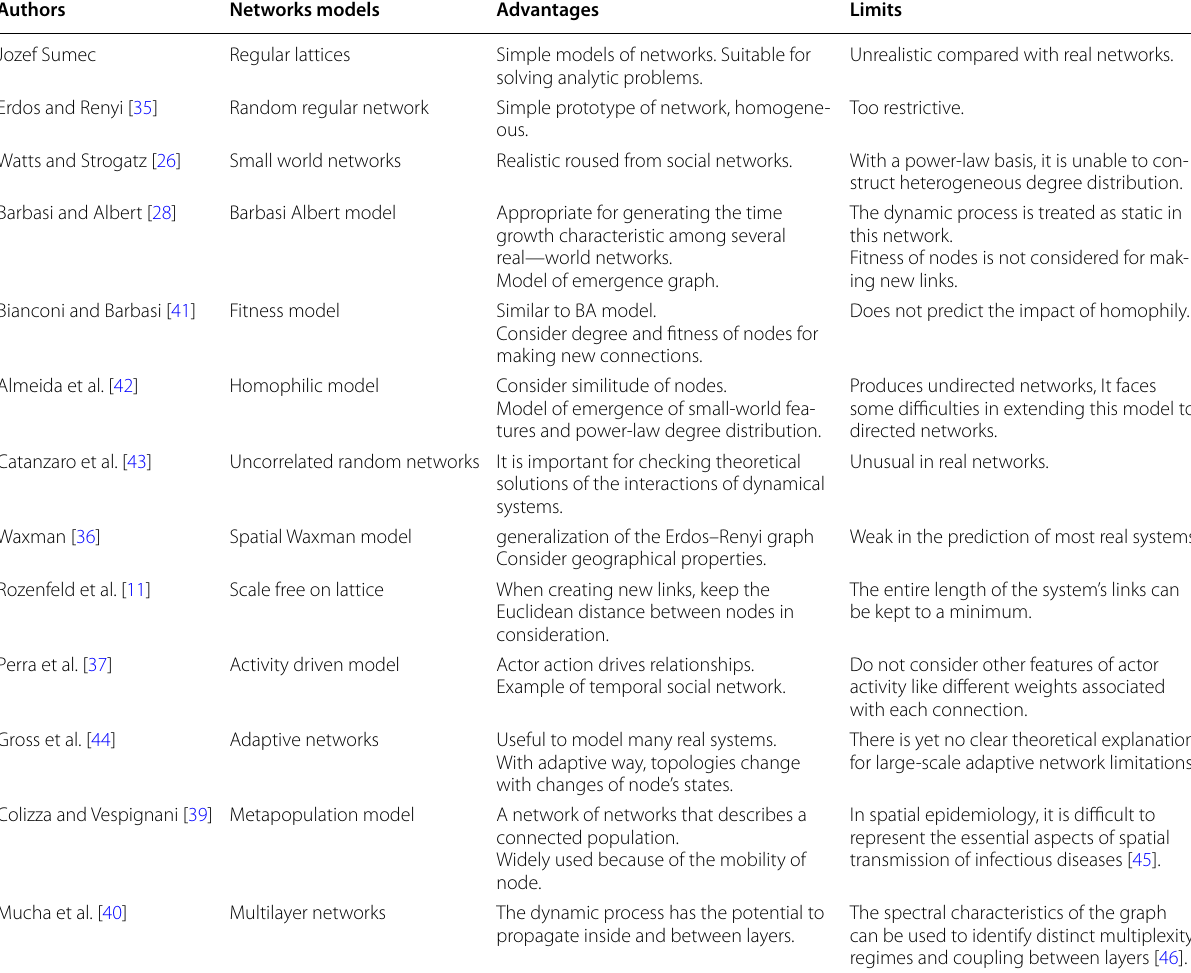
Table 1 Network models and their